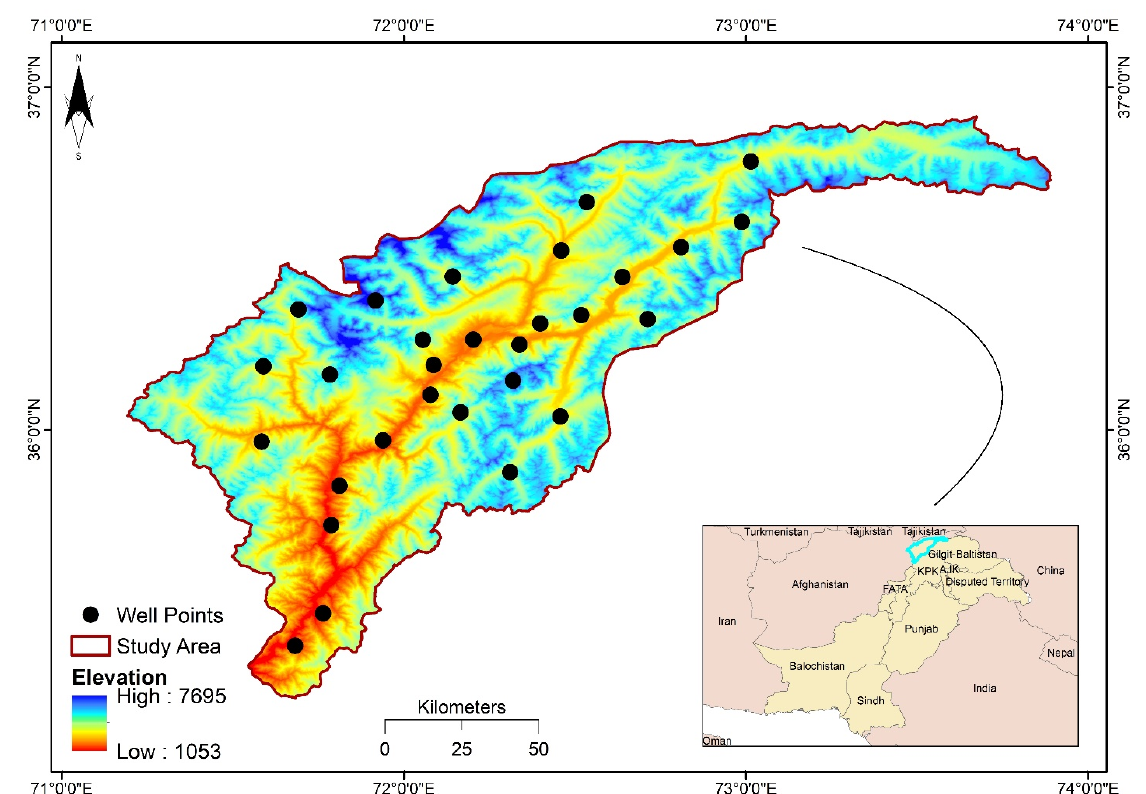
Figure 1. Study area map of Chitral district.